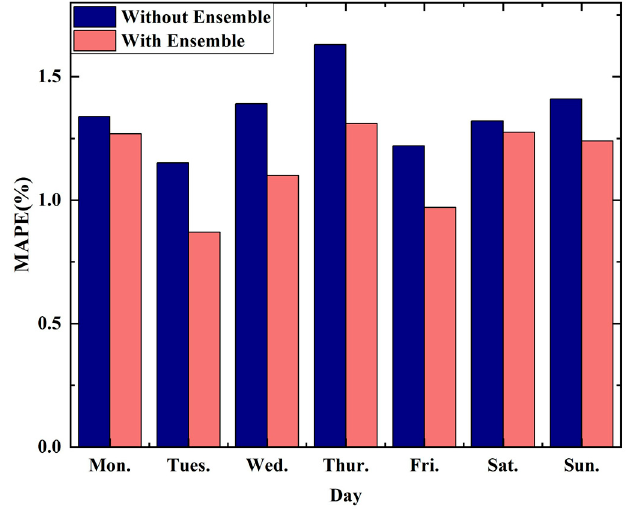
Figure 9. Comparison of the proposed method with ensemble thinking and the proposed method without ensemble thinking on individual days: MAPE, mean absolute percentage error.